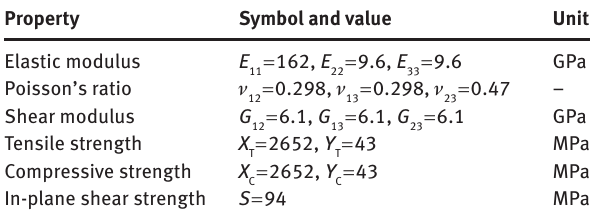
Table 1: Mechanical properties.